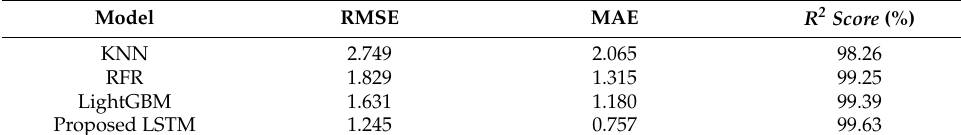
Figure 11. Comparison of original features and extended features by SW-SHAP. Table 5. Accuracy comparison of each model on the test set. The prediction accuracy of different models with extended features by the SW and SHAP methods were performed and evaluated with the proposed LSTM in this paper.